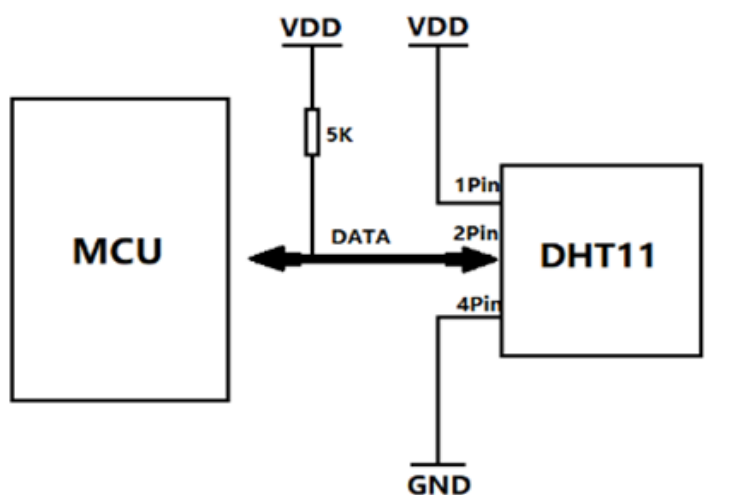
Figure 8. DHT11 temperature and humidity sensor.